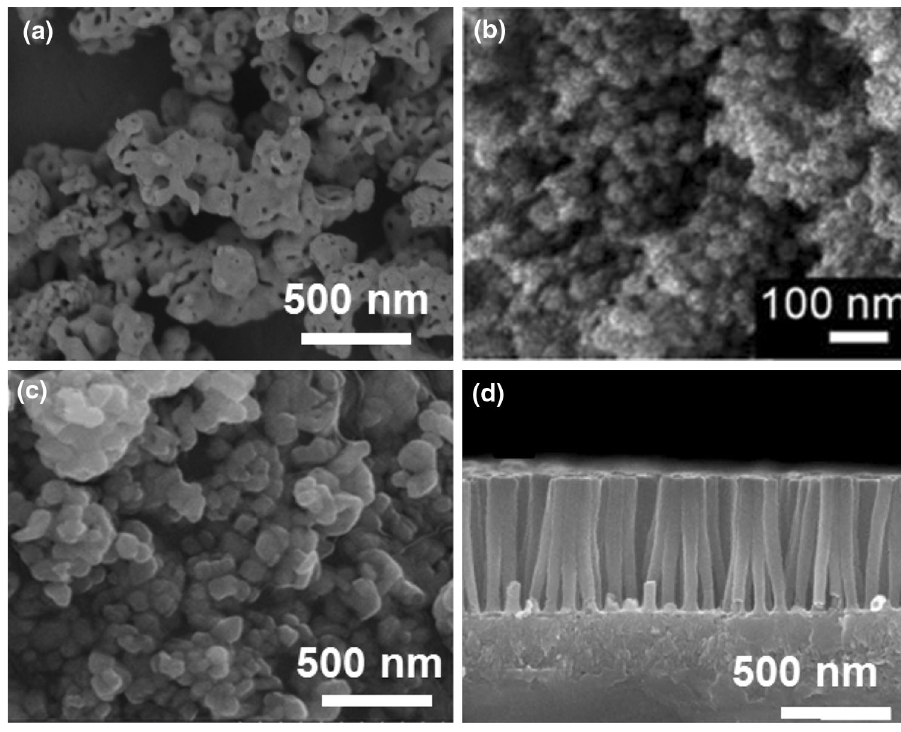
Fig. 2 SEM images of powder Ta 3 N 5 synthesized with different method: a direct nitridation of Ta 2 O 5 , adapted from [44] with permission from the PCCP Owner Societies, b decomposition using mesoporous g-C 3 N 4 template, adapted from [46] by permission of John Wiley & Sons Inc, c nitridation of Na 2 CO 3 -pretreated Ta 2 O 5 , adapted with permission from [42] Copyright (2012) American Chemical Society, and d nanorod Ba-Ta 3 N 5 film synthesized by nitridation